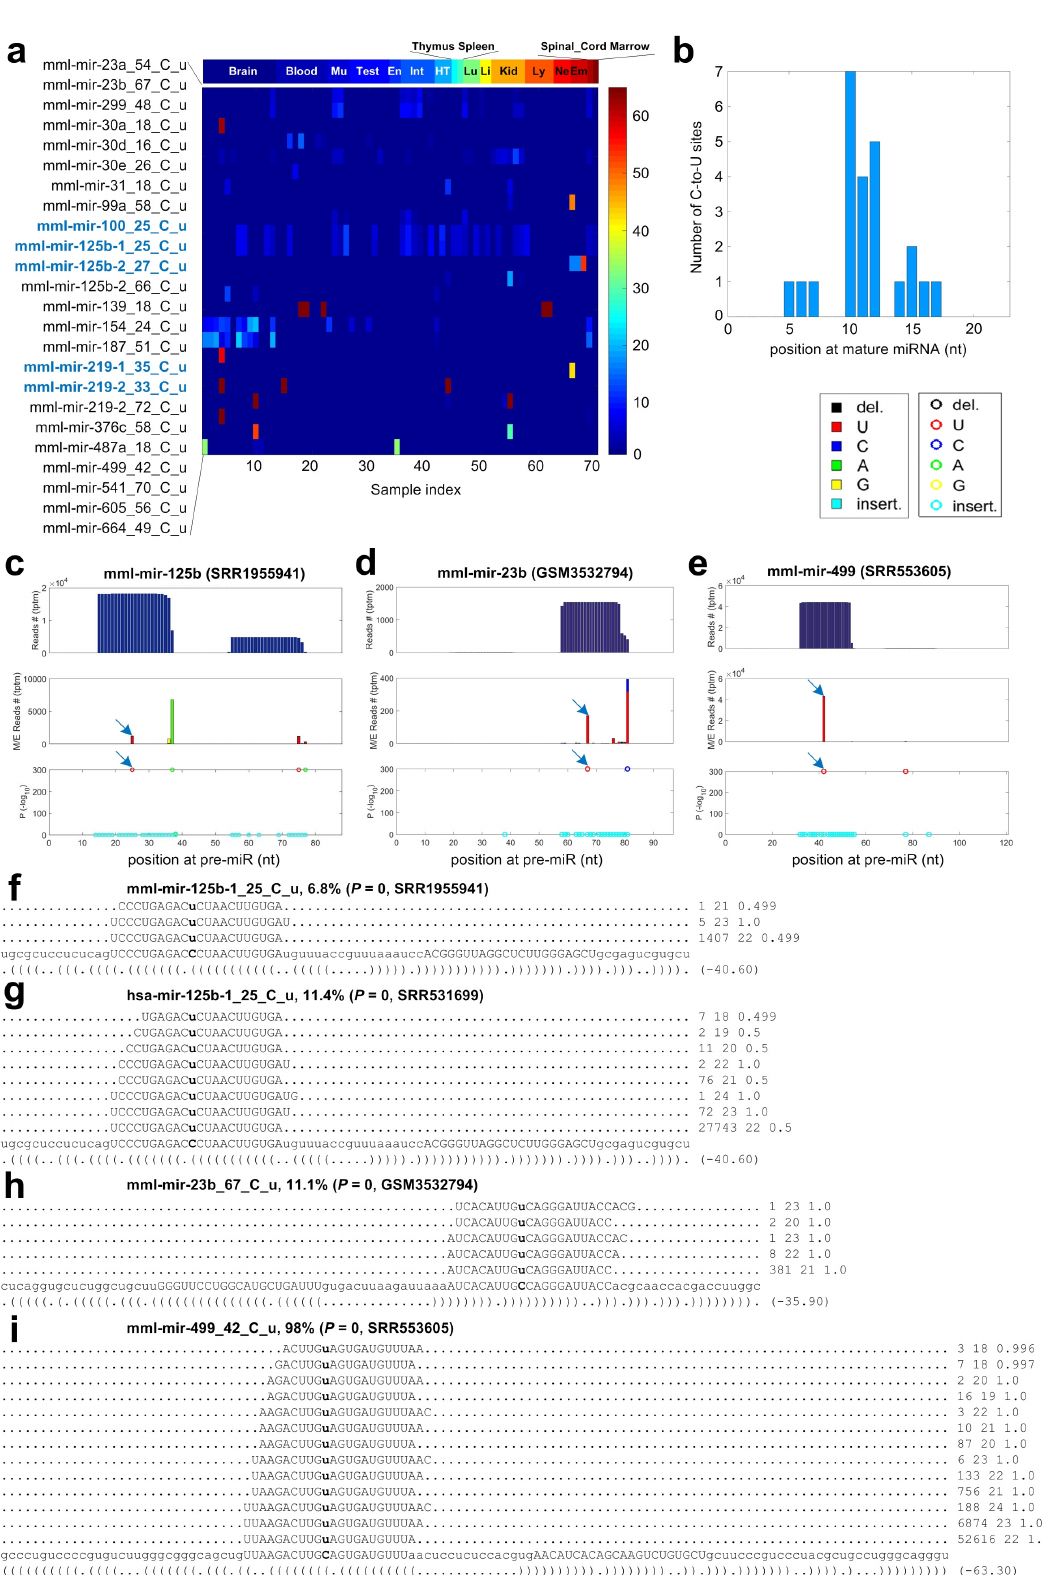
Figure 5. The details of 24 C-to-U editing sites identified in miRNAs of Macaca mulatta . Legends are the same as those in Figure 4. ( a ) The editing levels of the 24 C-to-U sites in the 70 selected sRNA-seq profiles. ( b ) The numbers of C-to-U sites at different positions of mature miRNAs. ( c ) The MiRME map of